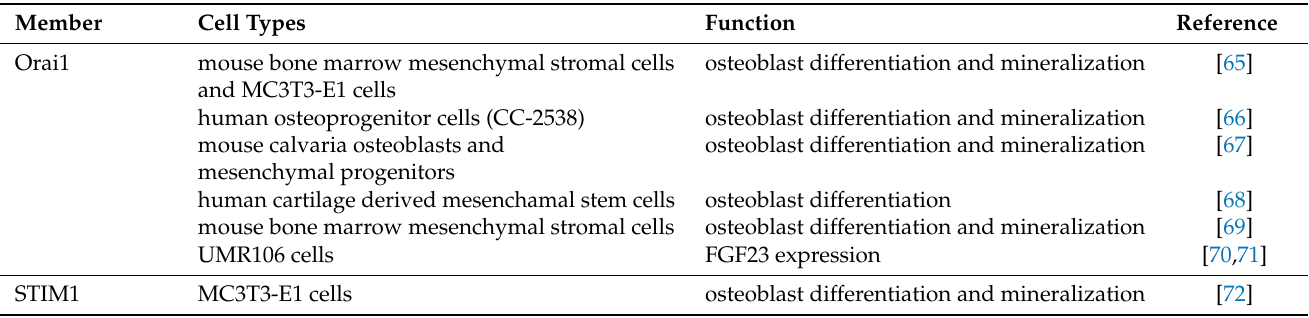
Table 3. Functional expression of Orai/STIM in osteoblast lineage cells.